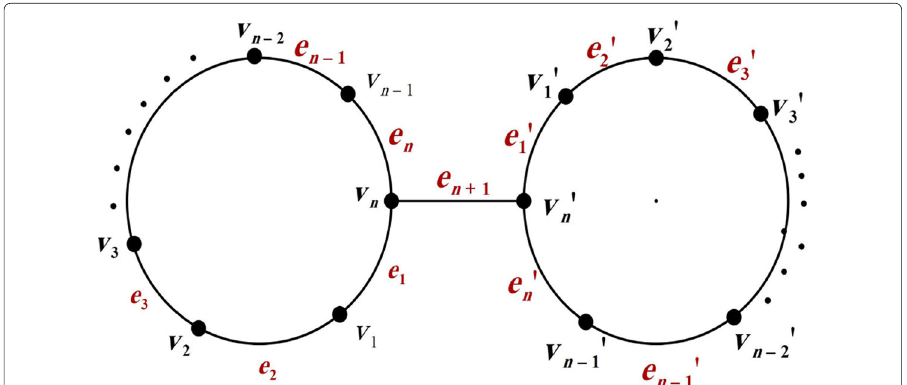
Fig. 14 The graphs K 2 (cid:4) C n with ordinary